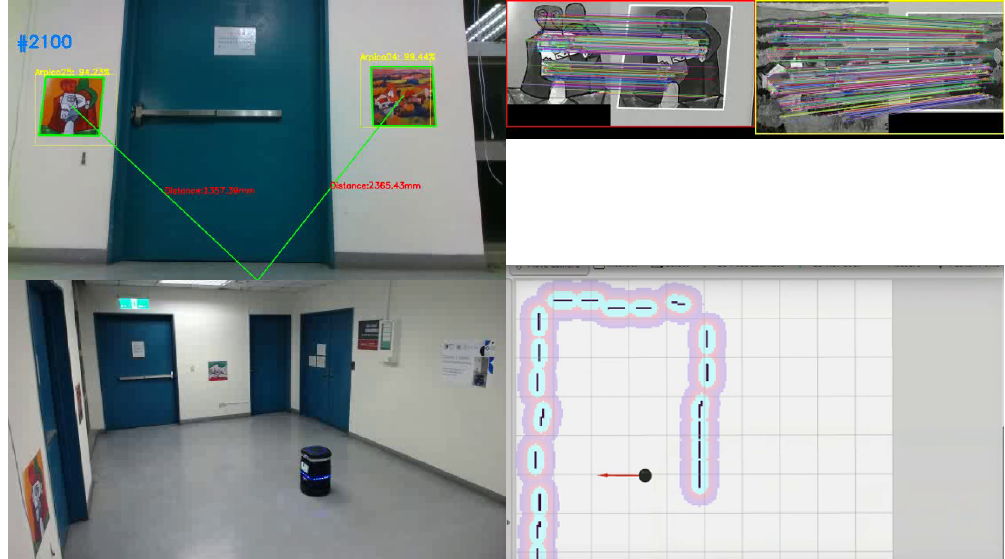
Figure 13. Robot Localization